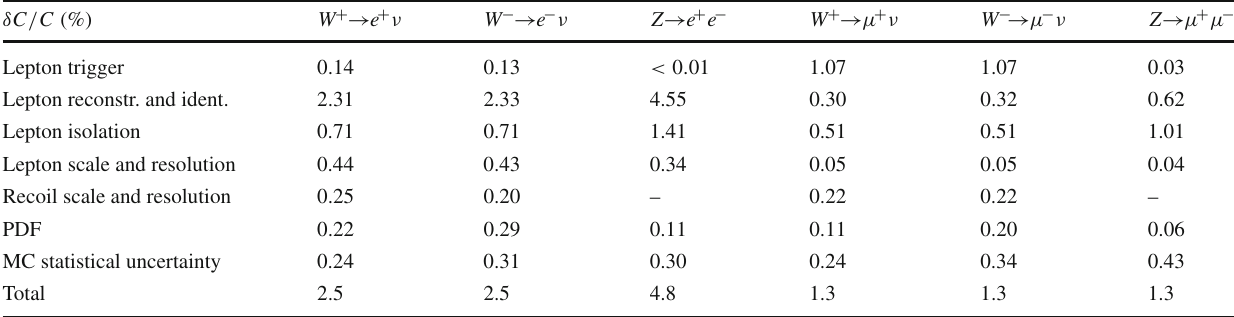
Table 3 Relative systematic uncertainties (%) in the correction factors C W , Z in different